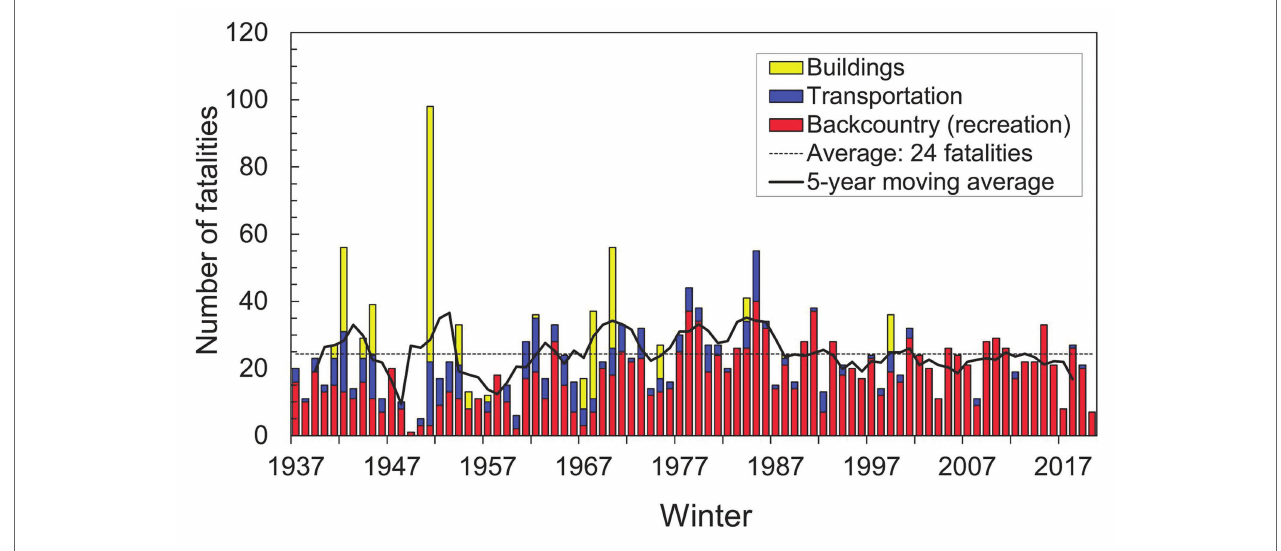
FIGURE 1 | Avalanche fatalities in the Swiss Alps for the period of 1936–1937 to 2019–2020 (84 years). In recent decades, most victims were caught during recreational activities such as skiing (“Backcountry”)—illustrating the emergence and growth of winter tourism. Victims on roads including ski runs are counted in “Transportation.” Victims in villages (“Buildings”) became far less frequent due to extensive mitigation works (updated from Schweizer et al.,